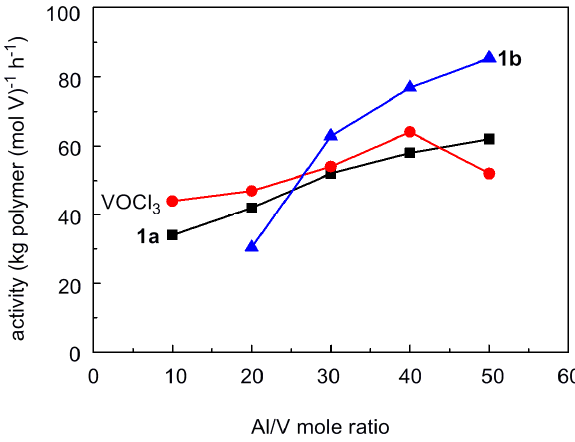
Figure 1. Effect of Al/V ratio on on activity of vanadium-based catalysts in ethylene/propylene polymerization. Reaction conditions: [V] = 0.5 mmol/L, [ETAC]/[V] = 10, hexane 100 mL, 30 °C, 30 min, 1 bar of ethylene/propylene (1/2, molar ratio) pressure.